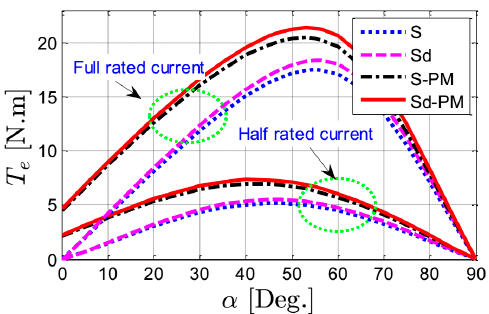
Figure 5. SynRM output torque ( T e ) as a function of current angle ( α ) at rated speed.